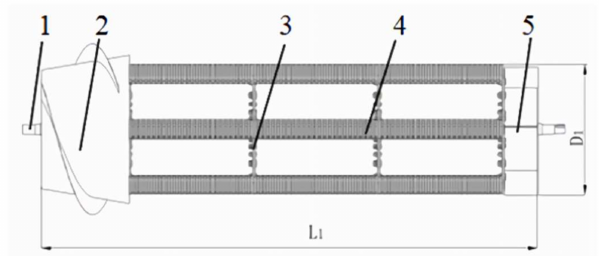
Figure 2. Structure diagram of threshing drum: 1. Main shaft; 2. conical spiral feed head; 3.